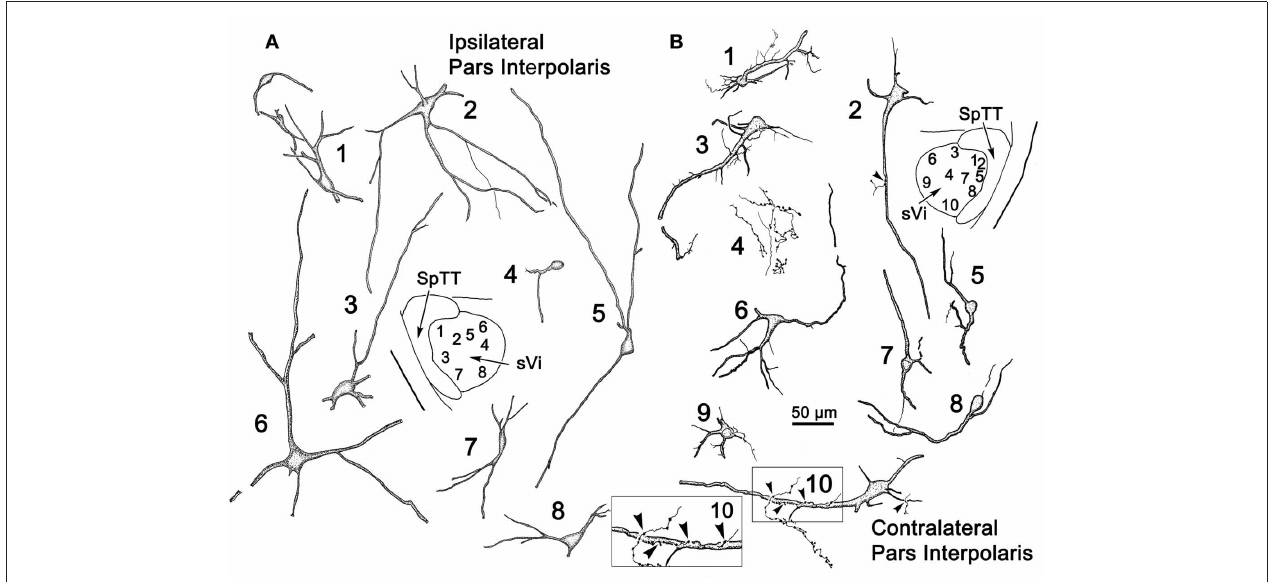
FIGURE 8 | Retrogradely labeled neurons and anterogradely labeled axons within sVi on the ipsilateral (A) and contralateral (B) side following the injection illustrated in Figure 7B. The location of the illustrated neurons is shown in the low magnification inserts.